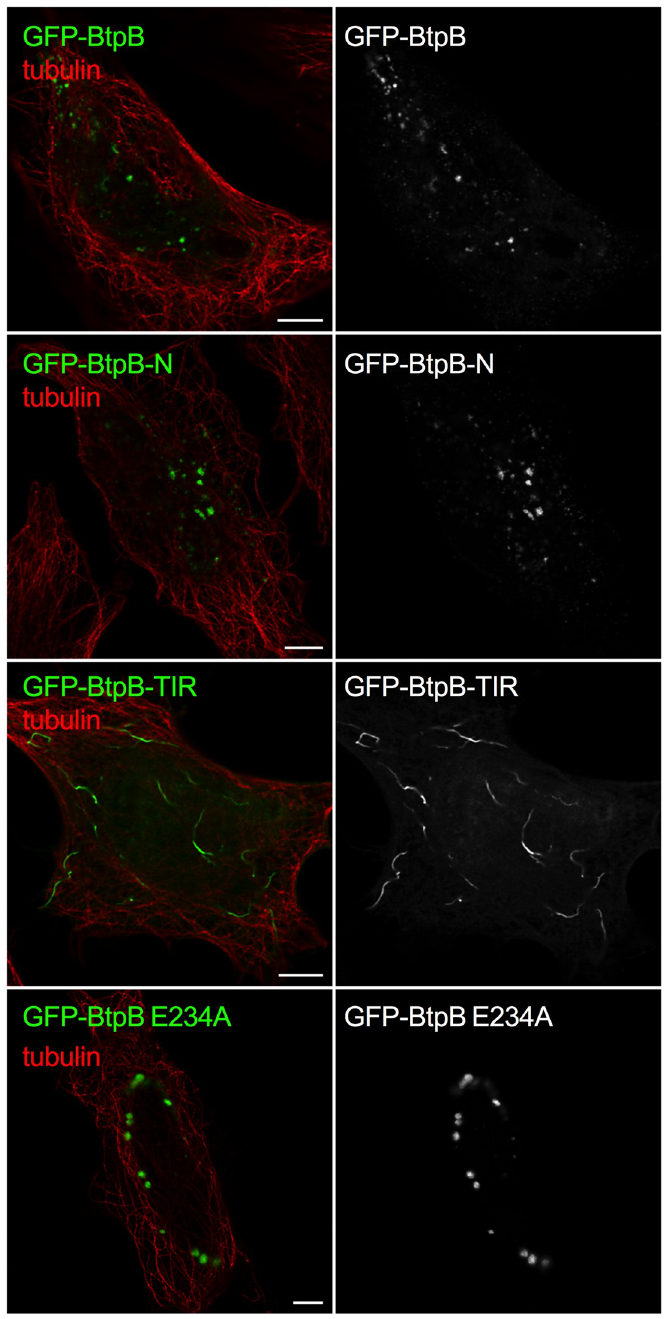
Fig 6. BtpB N-terminal domain is required for intracellular localization when ectopically expressed. The HeLa cells were transfected with GFP-BtpB, GFP-BtpB-N (1–139), GFP-BtpB-TIR (140–292) and GFP-BtpB E234A. Cells were then labelled for tubulin (red). Scale bars correspond to 5 μ m and all images obtained with Airyscan confocal imaging mode.